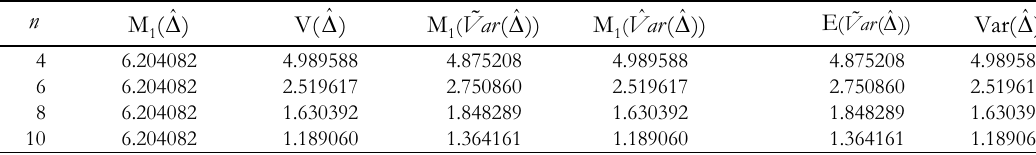
Data for the estimation of ˆ (cid:39) and ˆ Var( ) (cid:39) for f.p.1, obtained by generation of the whole sample space, compared with the theoretical values of E ˆ ( ( )) Var (cid:39) (cid:4) and